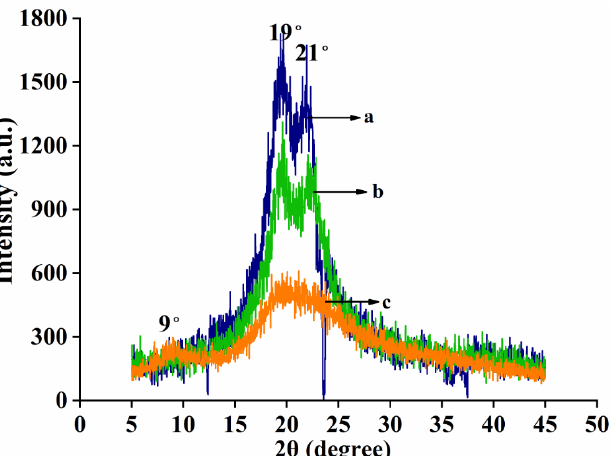
Figure 5. XRD patterns of (a) nylon6 nanofiber membranes; (b) nylon6/pig nail keratin composite nanofiber membranes; and (c) pure pig nail keratin.